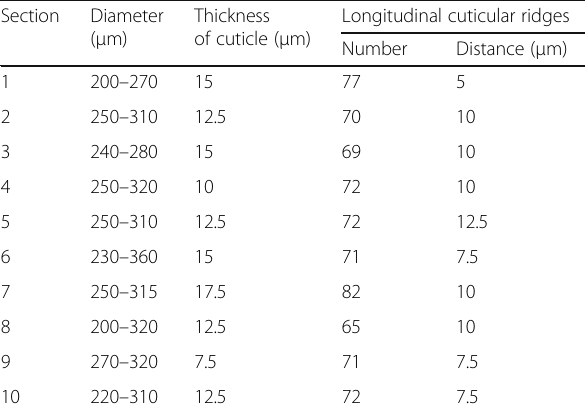
Table 1 Summary of the width and number of longitudinal ridges on the surface of Dirofilaria species in a dorsal lesion Section Diameter Thickness Longitudinal cuticular ridges ( μ m) of cuticle ( μ m)